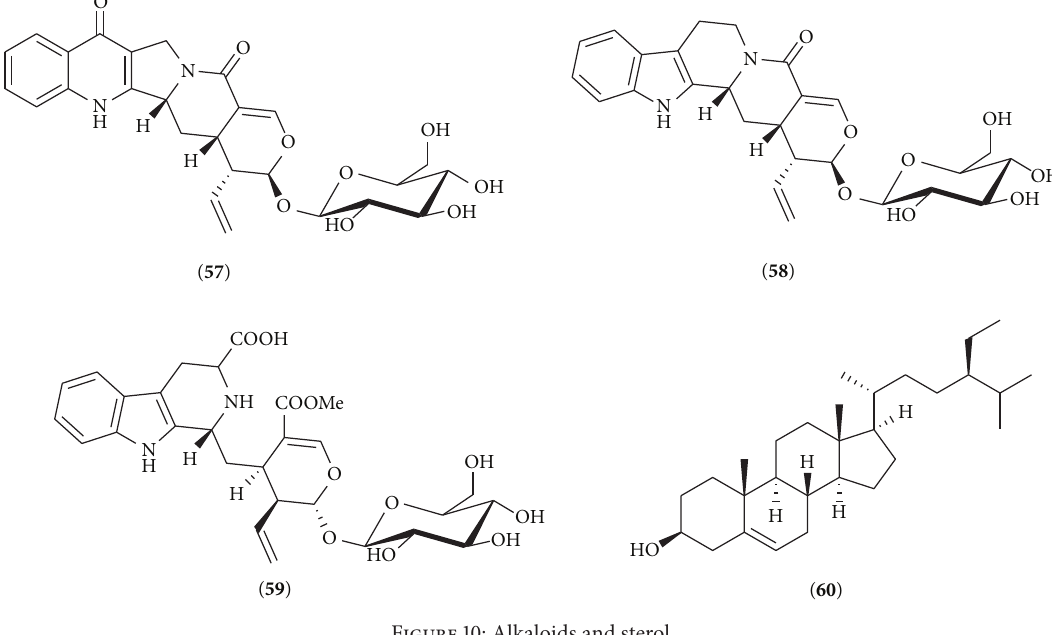
Figure 10: Alkaloids and